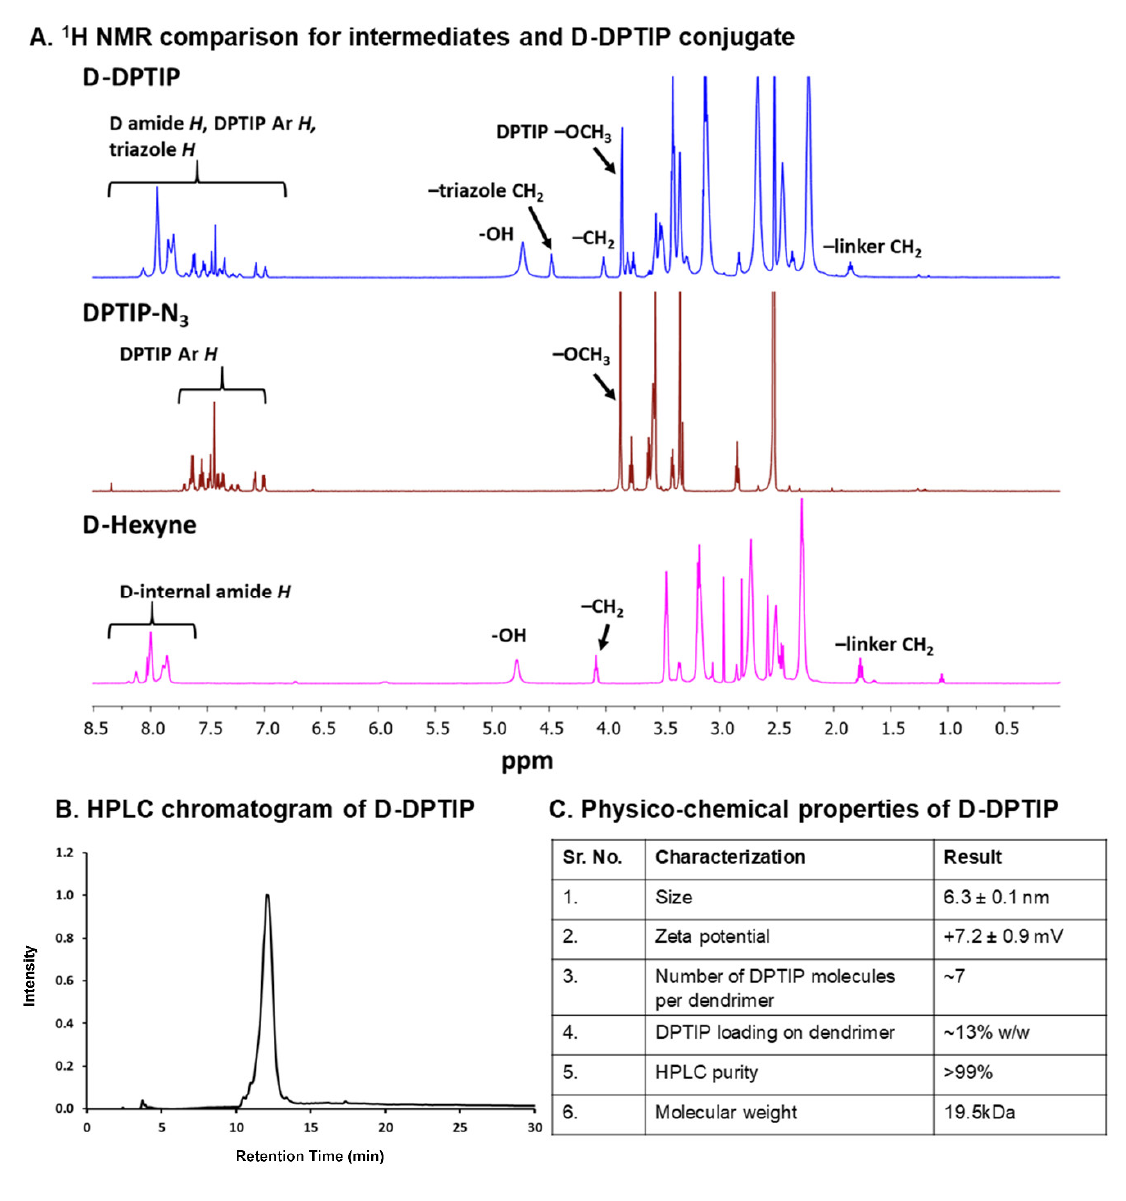
Figure 2. Physico-chemical characterization of intermediates and the D-DPTIP conjugate. ( A ) 1H NMR spectra showing the proton peaks of DPTIP-azide, and D-hexyne compared to the D-DPTIP conjugate. ( B ) HPLC chromatogram of D-DPTIP, retention time: 12.05 min, purity: 99.1%. ( C ) Table representing the physicochemical properties of the D-DPTIP conjugate.